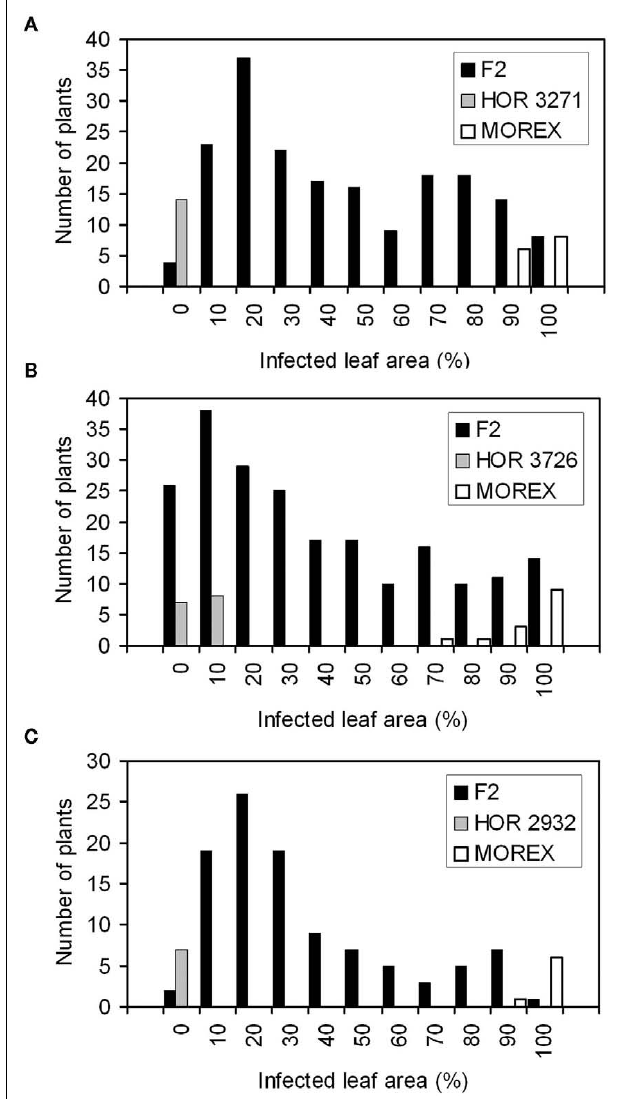
FIGURE 2 | Quantitative inheritance of seedling resistance of selected barley genotypes. Resistance to Bgh of three F2-mapping populations (A–C) derived from crosses between resistant accessions and cv. Morex was scored in a detached leaf assay 7days after inoculation of the second leaf of approximately 14-day-old